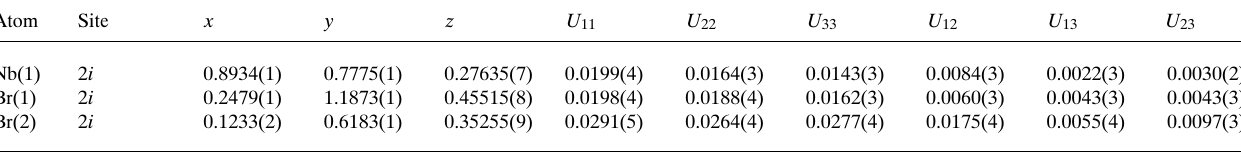
Table 2. Atomic coordinates and displacement parameters (in Å 2 )